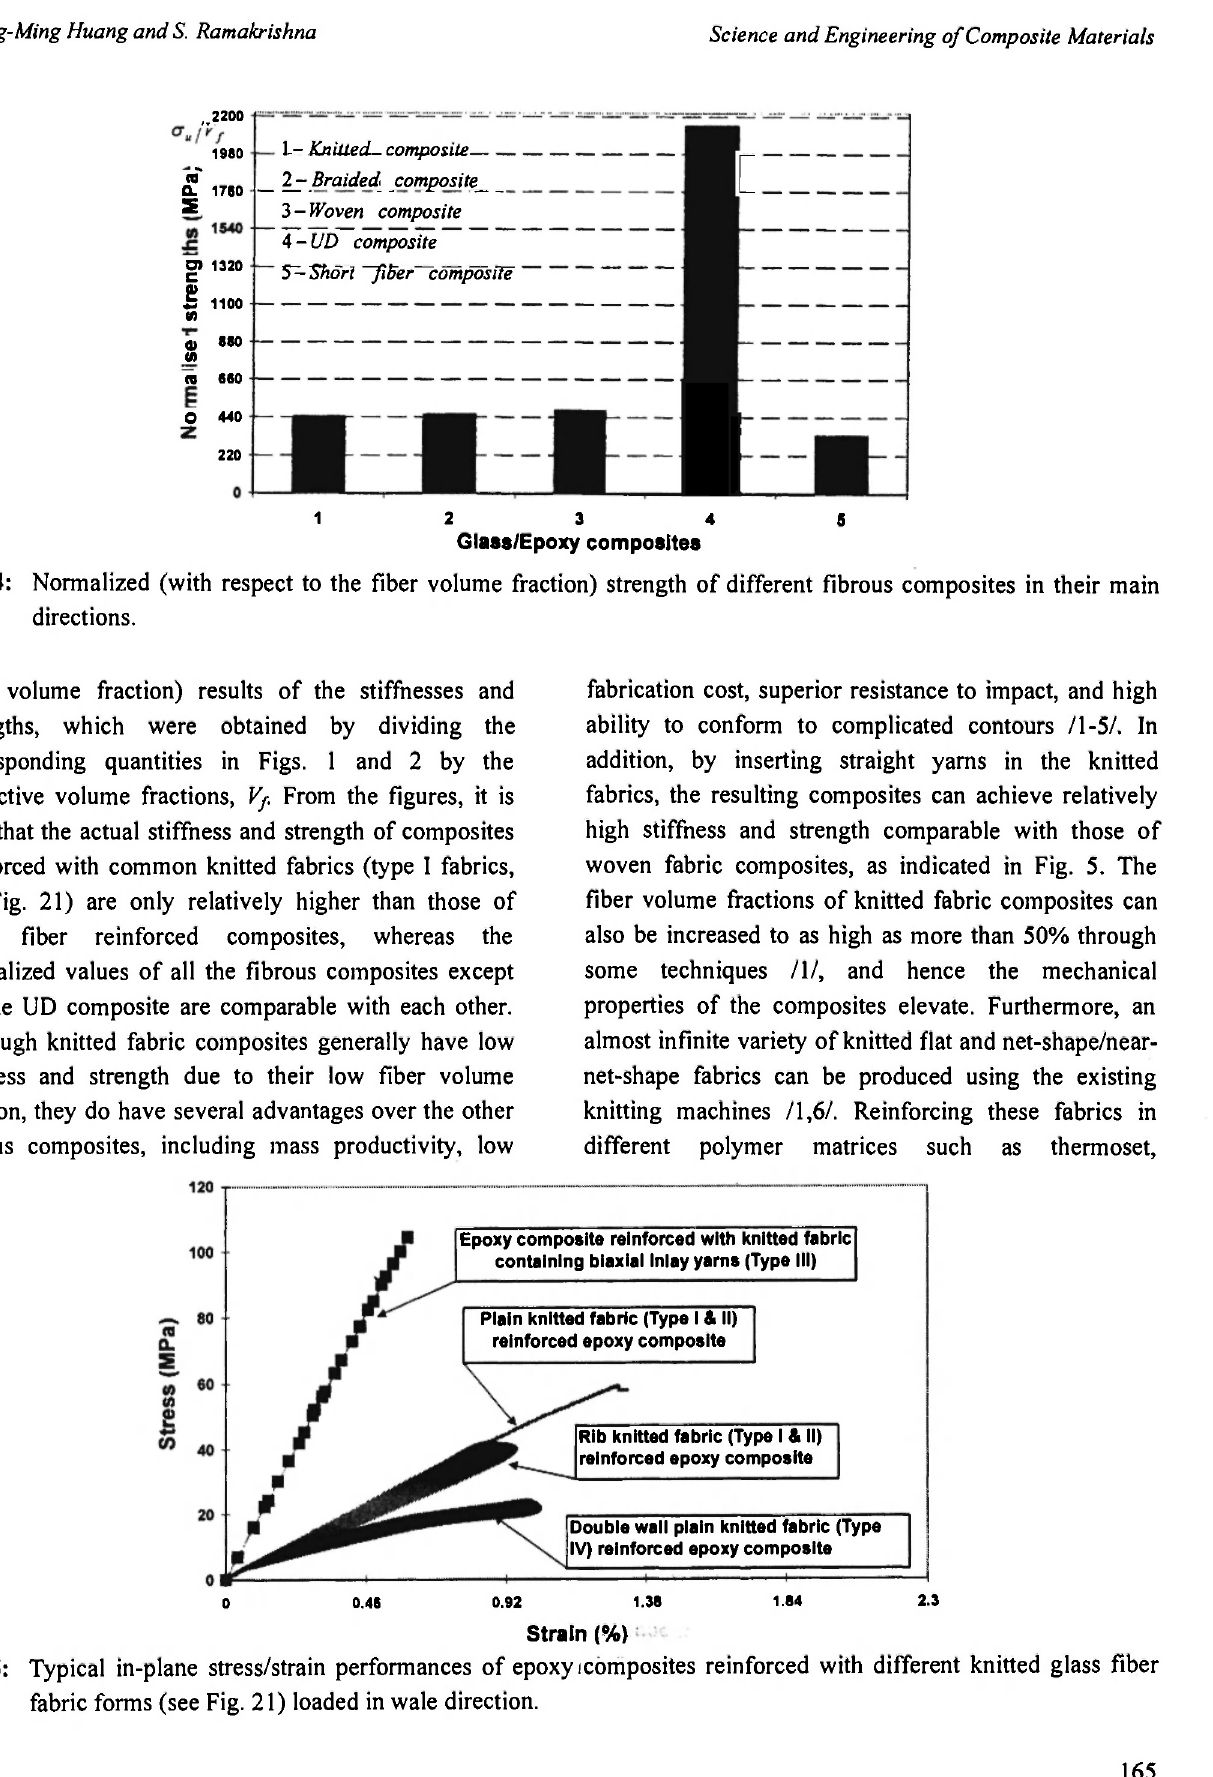
Typical in-plane stress/strain performances of epoxy composites reinforced with different knitted glass fiber Fig. 5: fabric forms (see Fig. 21) loaded in wale